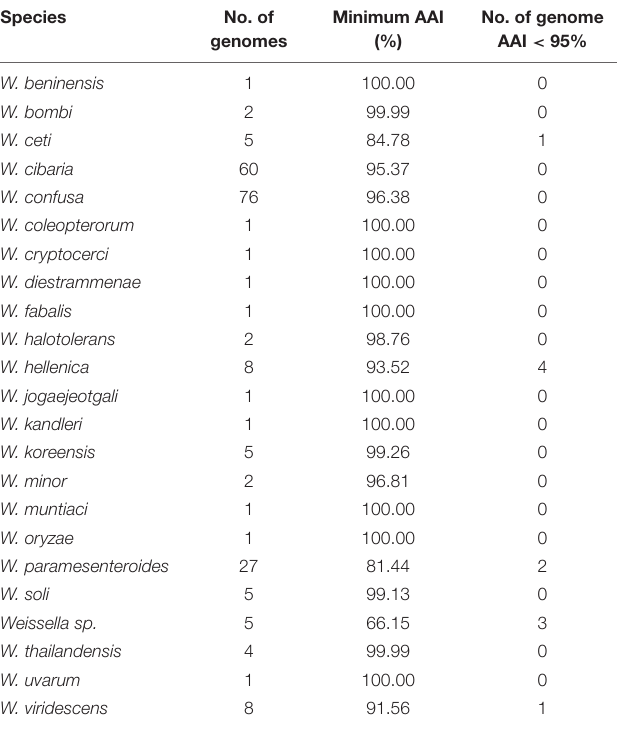
TABLE 2 | Average amino acid identity information among Weissella